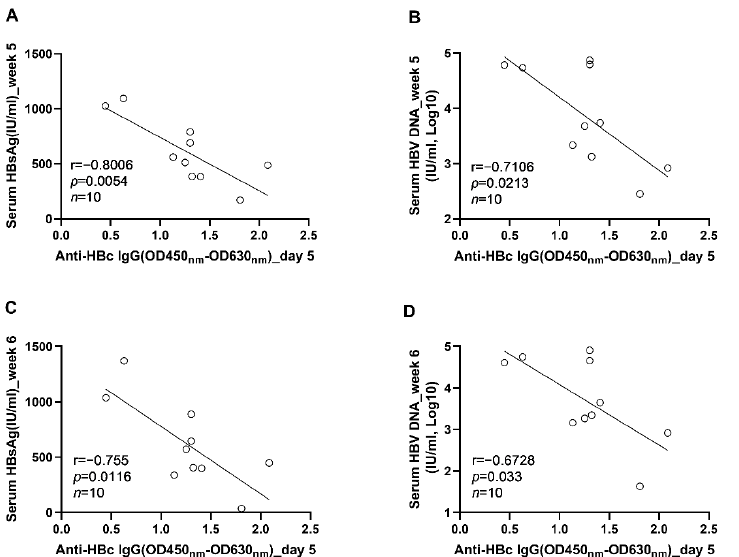
Figure 7. The correlations between the levels of anti-HBc IgG responses at the acute phase of infection and the levels of HBV replication at the phase of stable infection were verified in AAV8-1.3HBV infected C57BL/6J mice. ( A ) the correlation between the levels of anti-HBc IgG at 5 dpi and the serum HBsAg concentrations at 5 wpi; ( B ) the correlation between the levels of anti-HBc IgG at 5 days post infection and the serum HBV DNA concentrations at 5 wpi; ( C ) the correlation between the levels of anti-HBc IgG at 5 days post infection and the serum HBsAg concentrations at 6 wpi; ( D ) the correlation between the levels of anti-HBc IgG at 5 days post infection and the serum HBV DNA concentrations at 6 wpi. Statistical analysis was performed by the method of Pearson correlation ( n = 10).